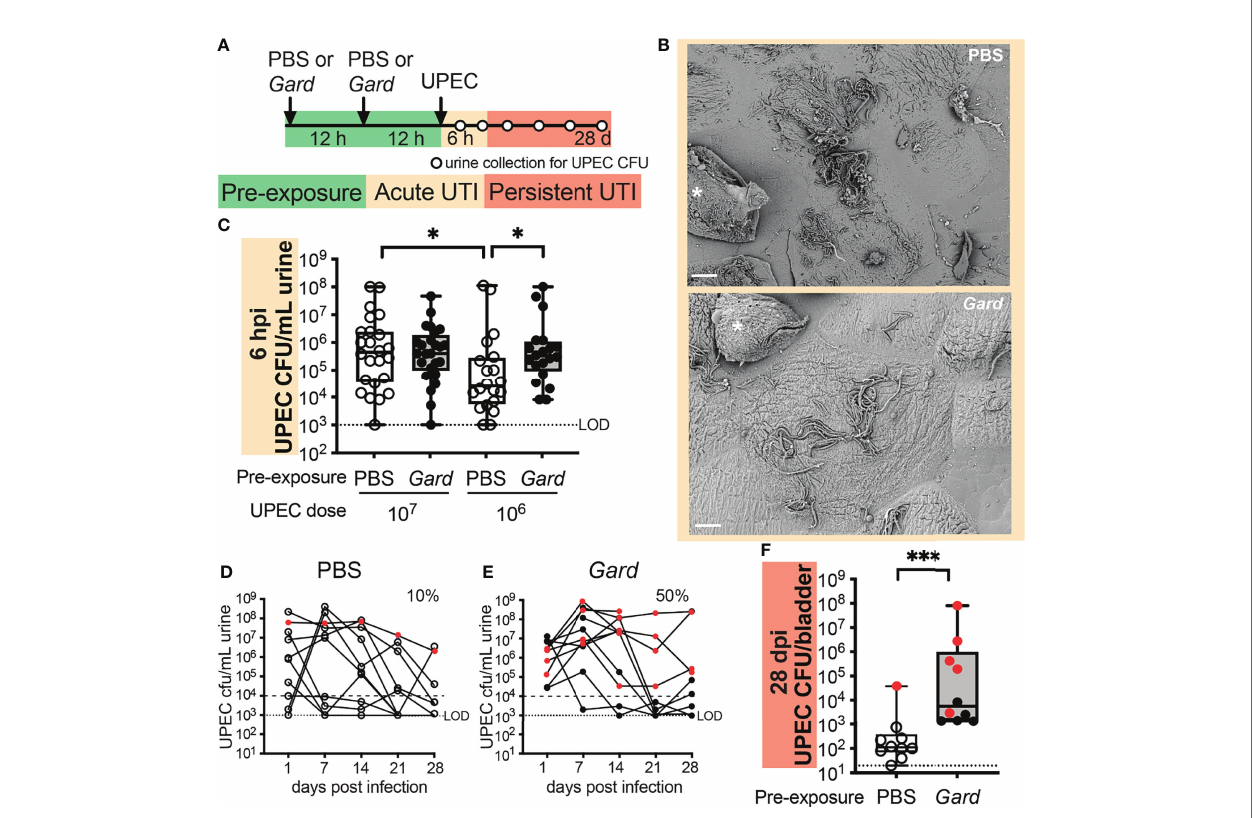
FIGURE 4 | Preexposure to Gardnerella increases acute UPEC bacteriuria and persistent infection. (A) Schematic of the mouse experiment time course. Dots on the timeline indicate when urine was collected for CFU enumeration. Data are from fi ve independent mouse experiments. (B) SEM images of bladders collected 6 h after UPEC infection from mice preexposed to PBS (top) or Gardnerella (bottom). Asterisks mark exfoliating umbrella cells. Scale bars = 20 m m. Refer to Supplementary Figure S3 for additional bladder SEM images. (C) Acute UPEC titers in urine collected 6 hpi, with each dot representing an individual mouse (10 7 n = 20 per group; 10 6 PBS n = 24, Gardnerella n = 25). * p < 0.05, Mann – Whitney U test. Box plot denotes the 25th and 75th percentiles with a line at the median and whiskers from min to max. (D, E) Time course of UPEC bacteriuria after a 10 7 CFU inoculation. Red symbols indicate mice that had UPEC bacteriuria >10 4 CFU/ml in each weekly urine sample. (F) UPEC titers in bladder homogenates collected 28 dpi. Each dot represents an individual mouse ( n = 10 per group). Red symbols indicate mice that had UPEC bacteriuria >10 4 CFU/ml in each weekly urine sample. LOD, limit of detection. *** p < 0.001, Mann – Whitney U test. Box